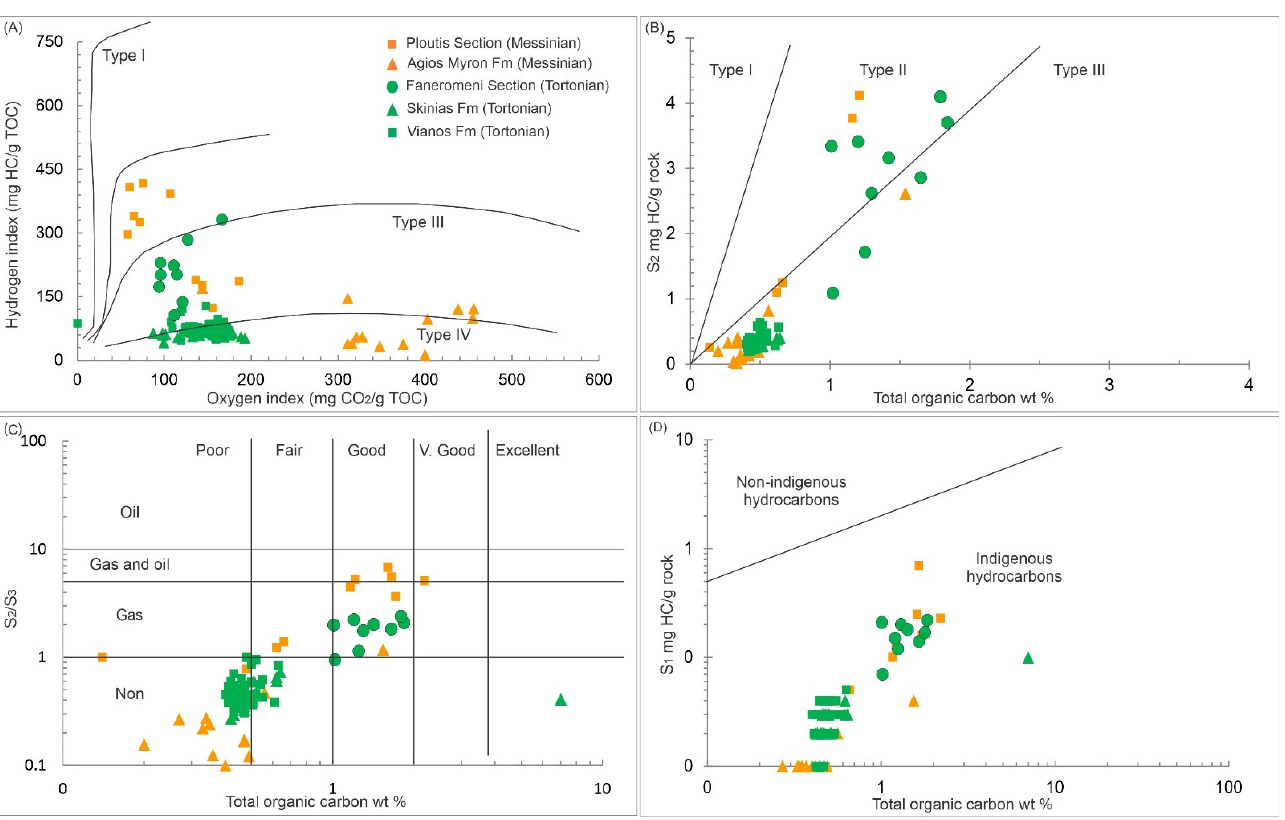
Figure 5. Evaluation of the kerogen type in the examined sedimentary rocks: ( A ) Classification diagram of hydrogen index vs. oxygen index kerogen, ( B ) Bi-plot of S2 vs. total organic carbon, ( C ) S2/S3 vs. total organic carbon, and ( D ) S1 vs. total organic carbon cross-plots. These plots suggest that Moulia Fm (at Faneromeni) and Ploutis section could represent source rocks with potential to generate gas. In contrast, Viannos Fm, Skinias Fm and Agios Myron Fm contain principally organic matter of kerogen IV, with no or little hydrocarbon generative potential. Green color refers to samples that are Tortonian in age, whereas orange color refers to samples that are Messinian in age.